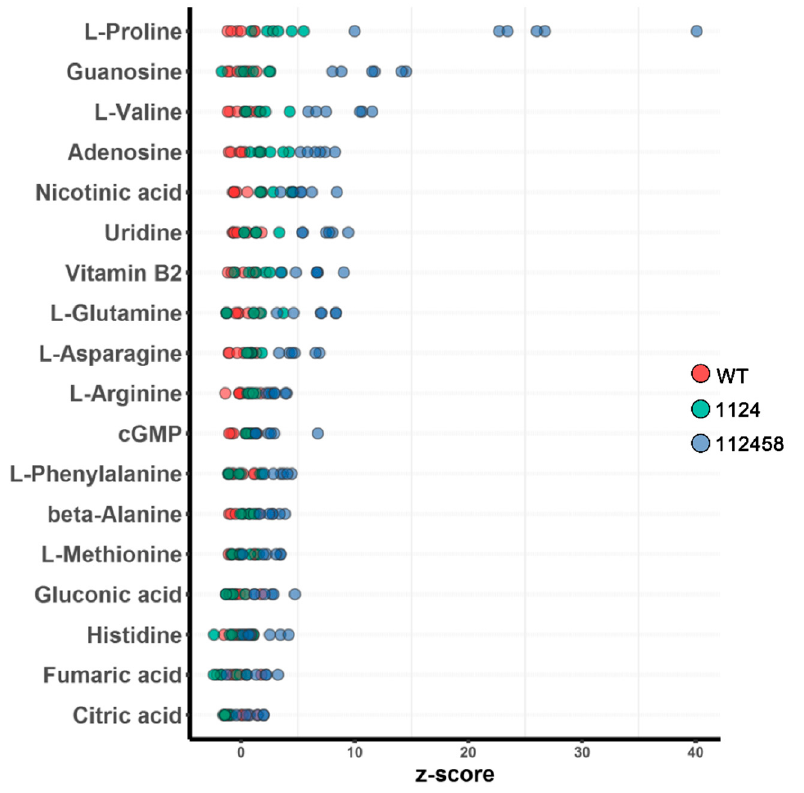
Figure 3. Comparison of metabolite levels in WT (red), 1124 (green), and 112458 (blue) plants.